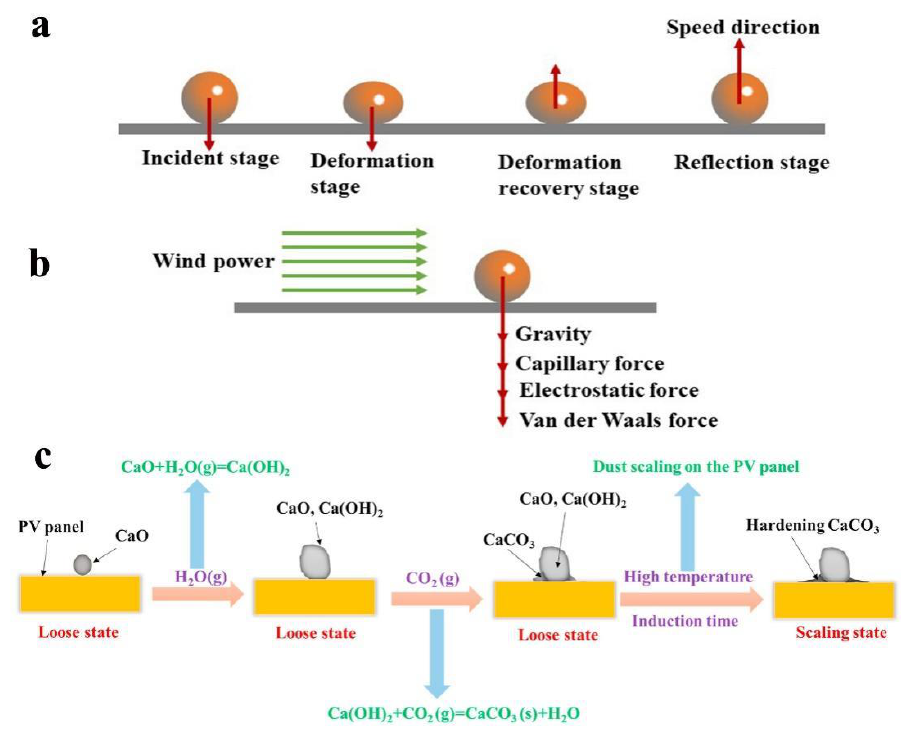
Figure 3. ( a ) Diagram of collisional adhesion of dust particles. ( b ) Adhesion and desorption of dust particles on a solid surface by external forces. ( c ) Schematic diagram of the scaling process of dust, reproduced with permission from Ref. [65].